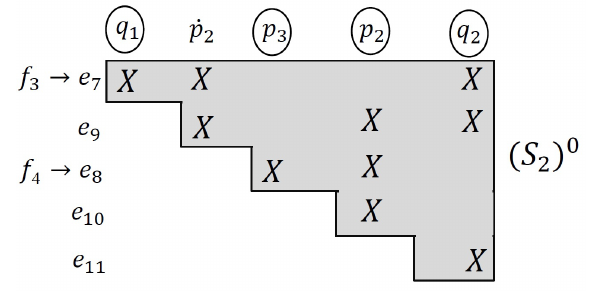
Figure 5. DM decomposition of S 2